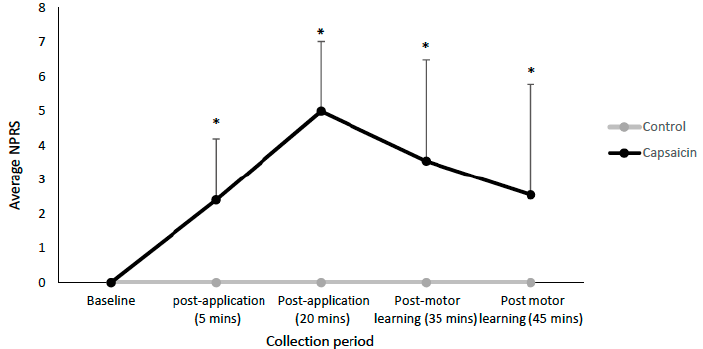
Figure 3. Line-graph depicting the average NPRS ratings for the capsaicin and control groups. Significant differences are indicated by asterisks (all p < 0.05). Error bars represent the standard deviation.